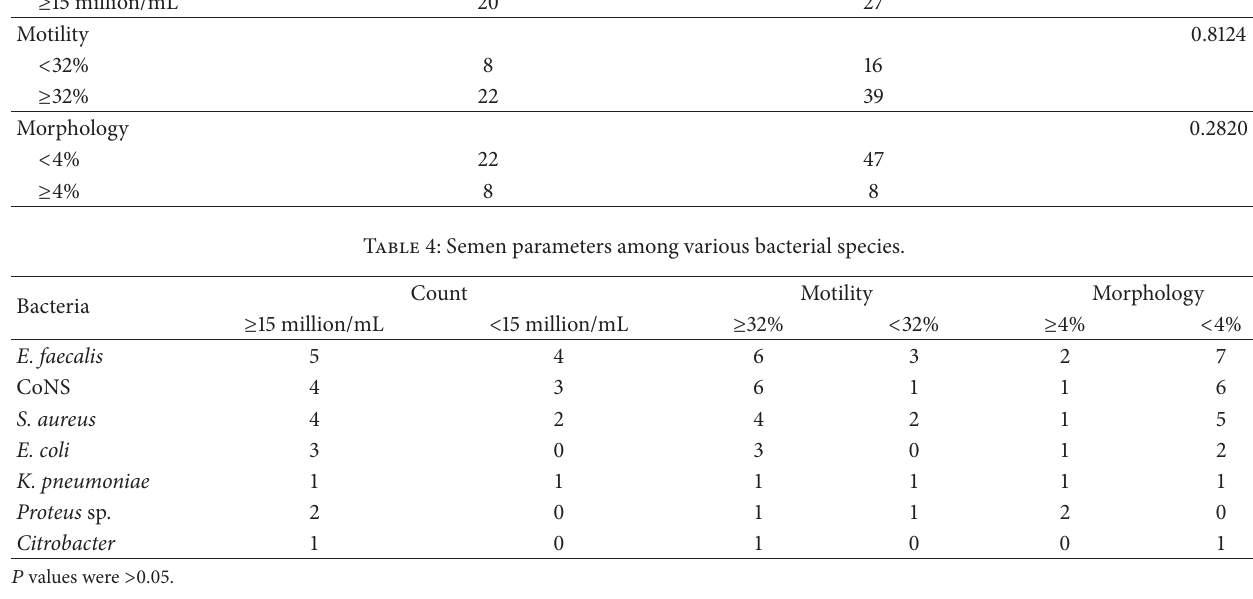
Table 5: Antibiotic susceptibility profile of bacterial